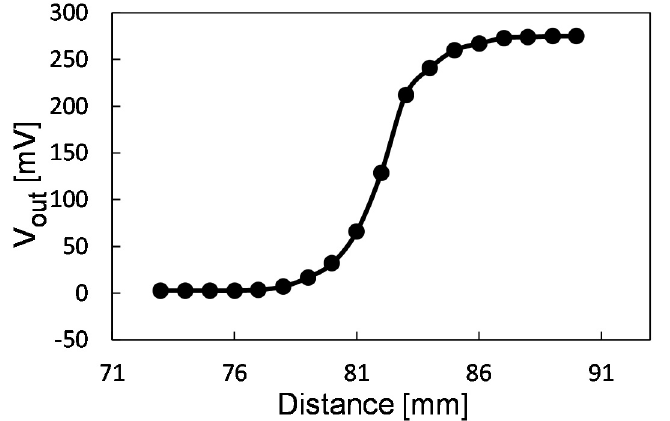
Figure 12. Relationship between output voltage and distance between superconducting coil and suspended object.